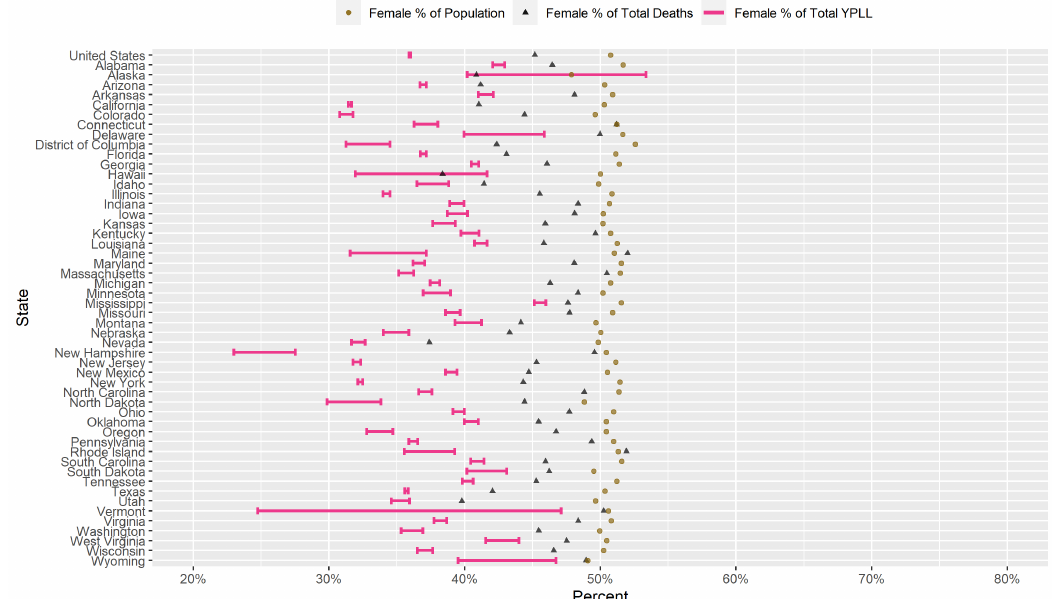
Figure 2. Conservative 95% interval estimates of the percentage of total COVID-19-attributable YPLL before age 75, the percentage of total COVID-19 deaths, and the percent population shares for females in the U.S. and in each of the 50 states and D.C. Quantities calculated with respect to cumulative COVID-19 deaths according to data from the National Center for Health Statistics as of 31 March 2021.